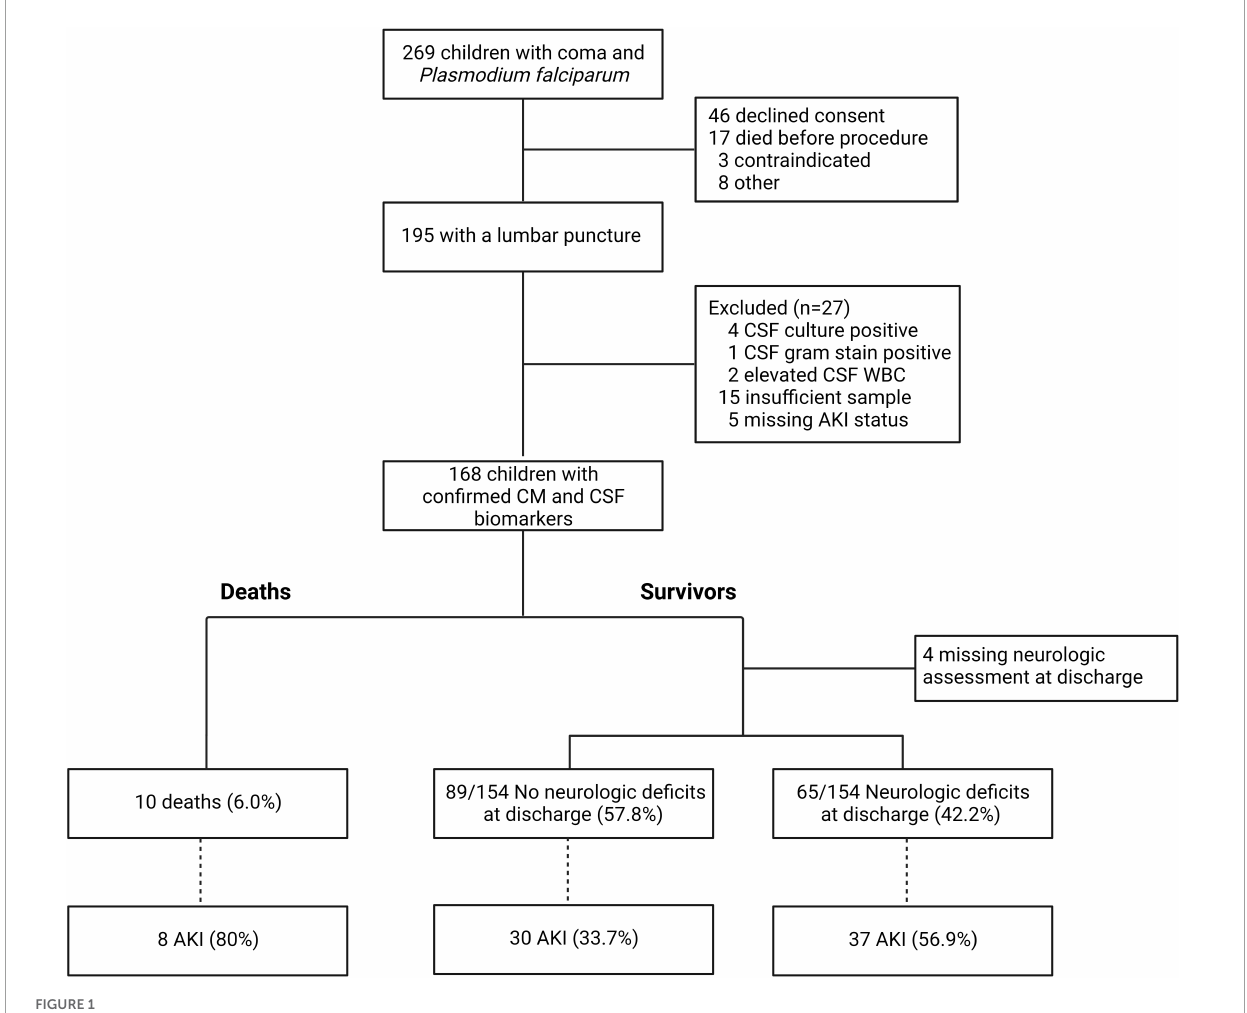
FIGURE1 Flow diagram of study